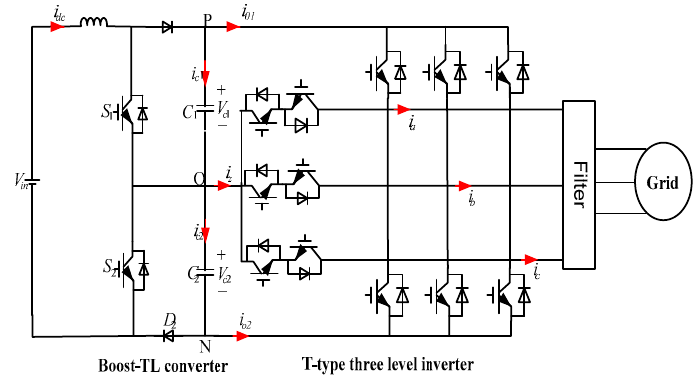
Figure 1. BTL and T-type three-level inverter.